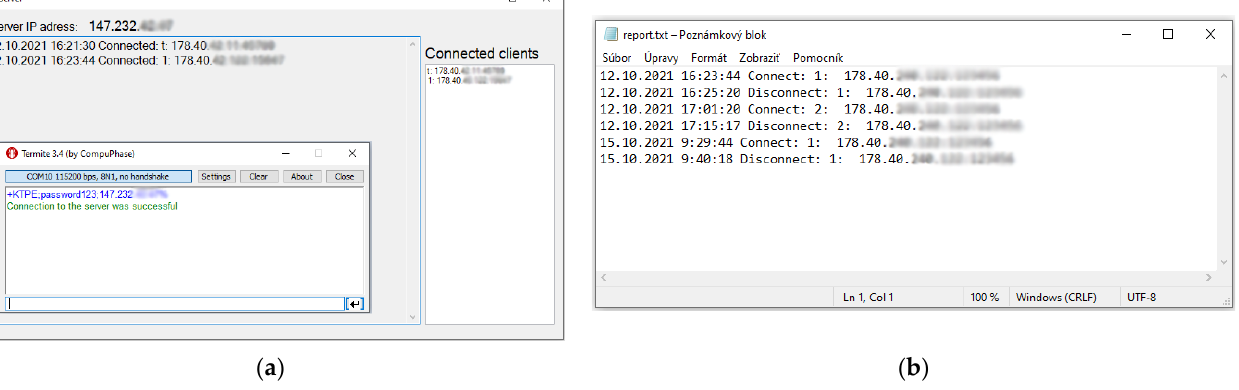
Figure 9. ( a ) The application on the server displays the connected devices. The Termite application (terminal) indicates the success of the IoT monitoring device connection. ( b ) Connection report from the server.